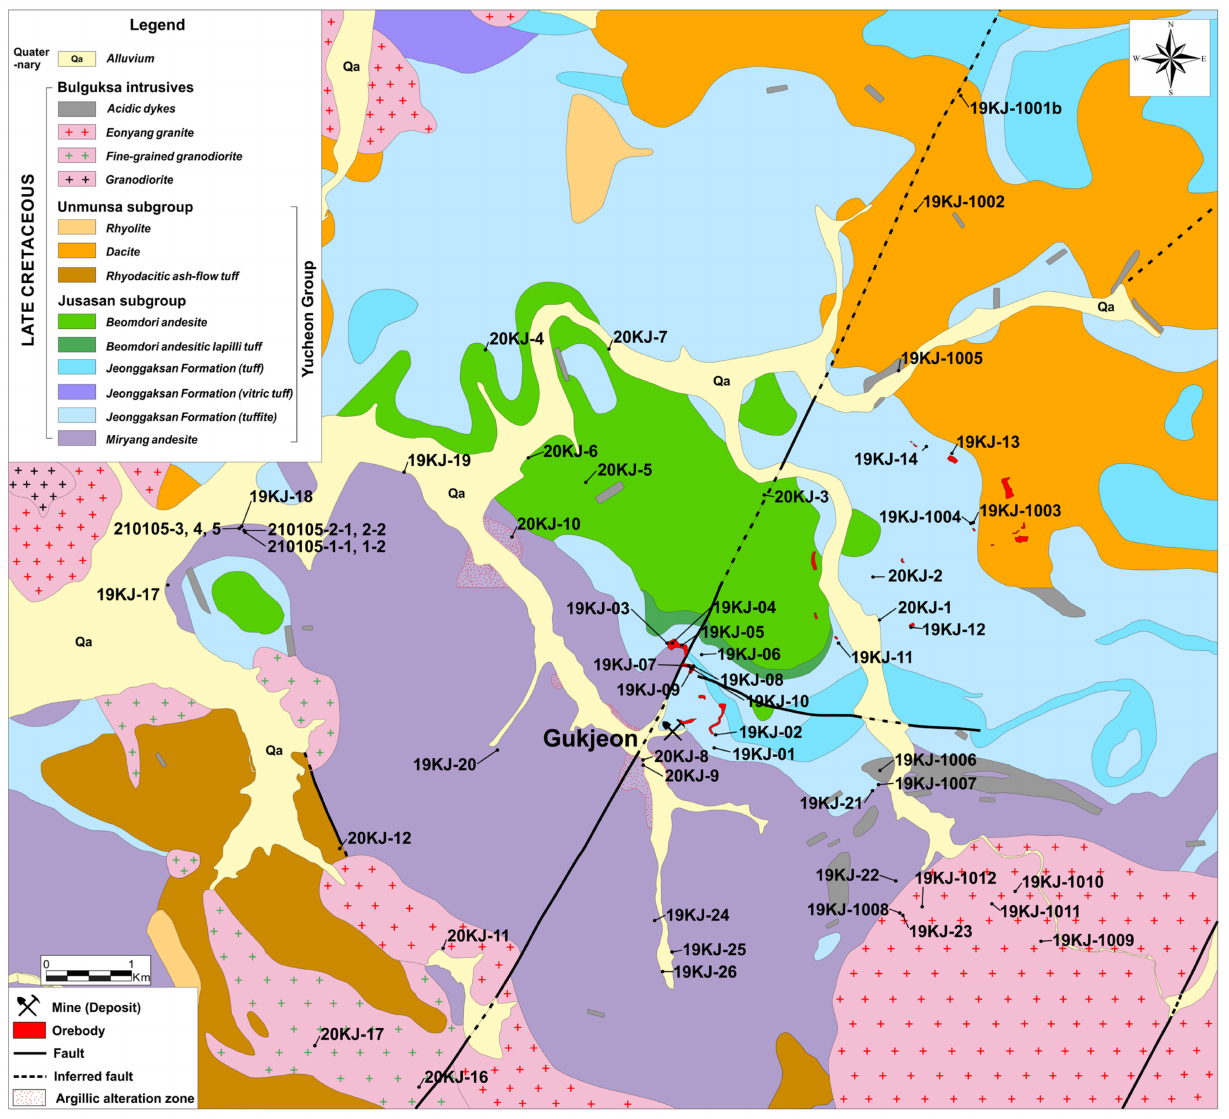
Figure 2. Geologic map and sample locality of the study area (modified from